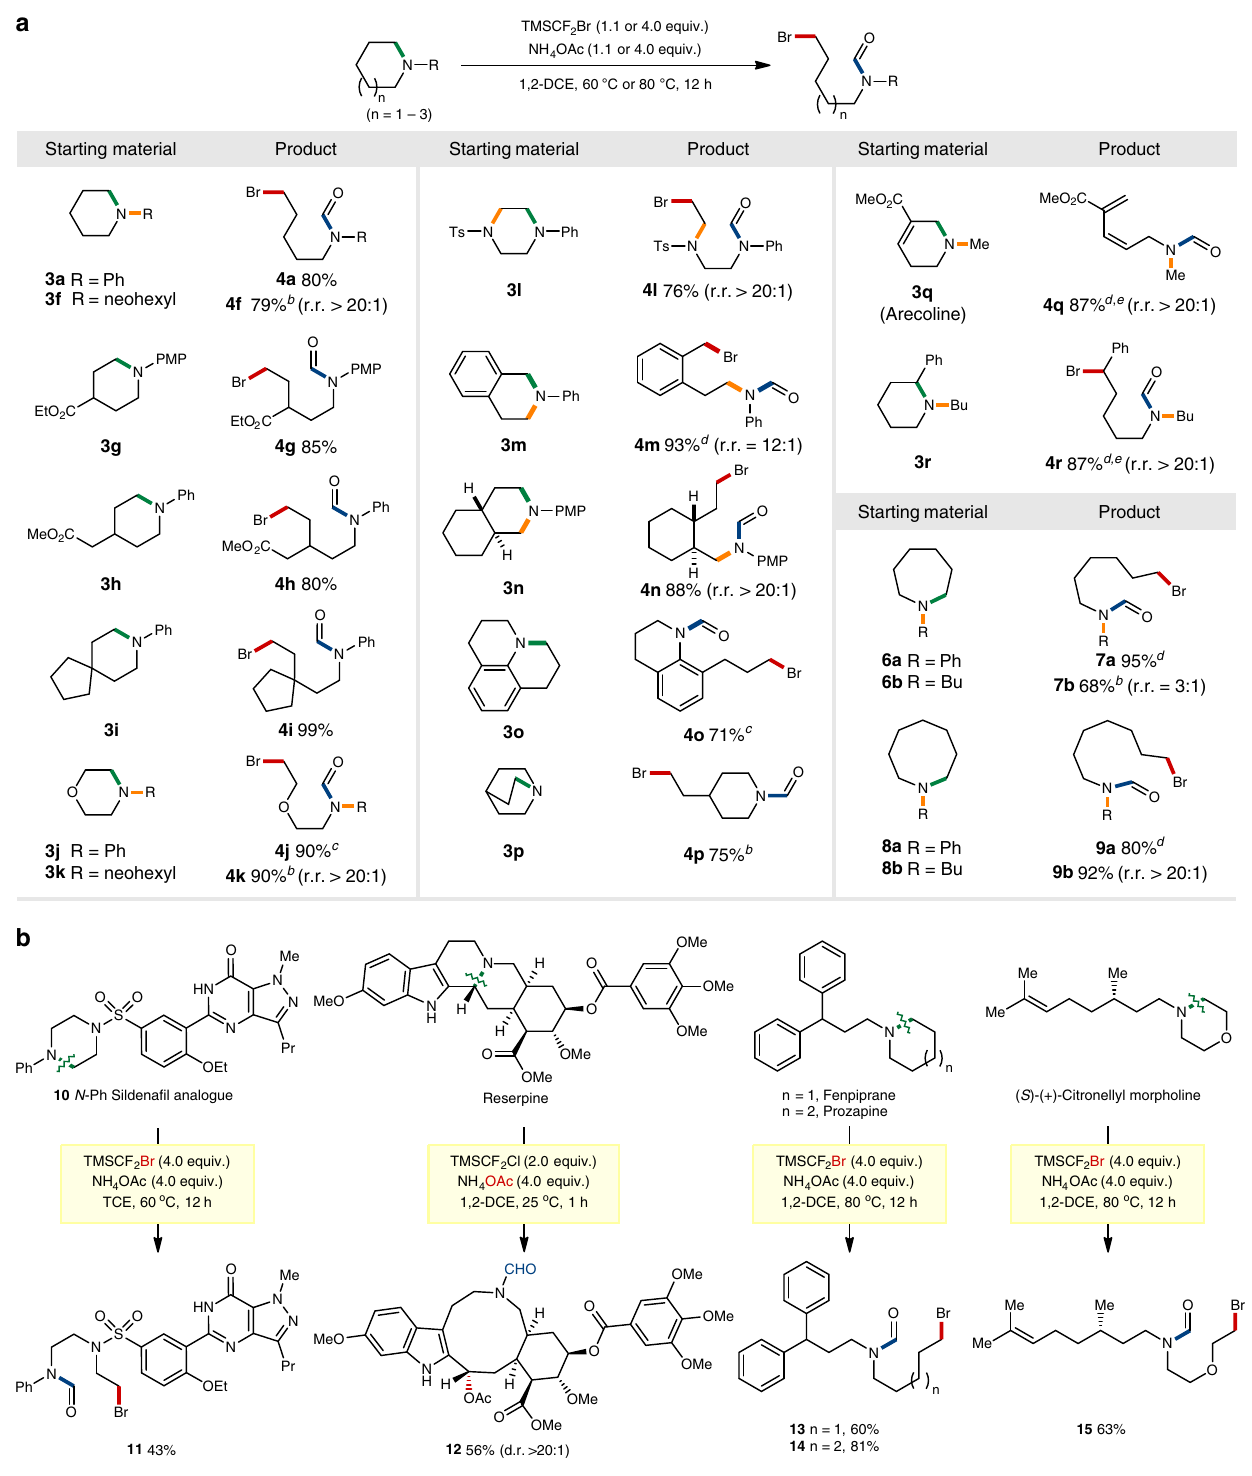
Fig. 6 Reaction of six-membered and larger cyclic amines. a Substrate scope; a reaction conditions: unless otherwise indicated, all reactions were performed on a 0.2 mmol scale using cyclic amine (1.0 equiv.), TMSCF 2 Br (4.0 equiv.), NH 4 OAc (4.0 equiv.) and 1,2-DCE (0.5 mL) at 60 °C. regioselectivity ratios (r.r.) were determined by 1 H NMR spectroscopy of crude mixtures. b 80 °C. c 40 °C. d 25 °C. e 1.1 equiv. of TMSCF 2 Br and 1.1 equiv. of NH 4 OAc. PMP para -methoxyphenyl. b Late-stage ring-opening functionalization of biologically relevant